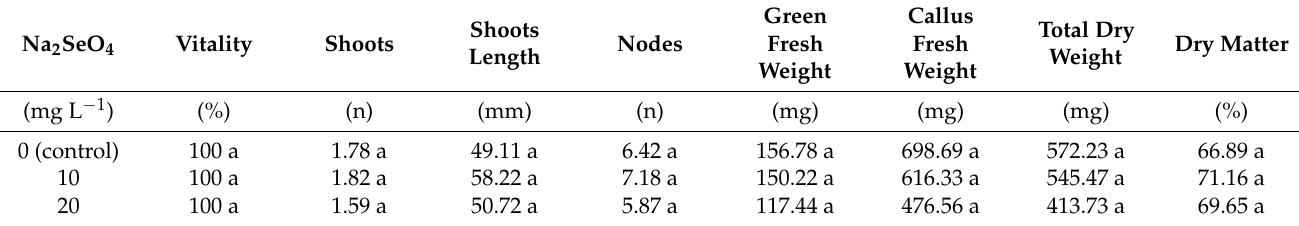
Table 3. Average values of the three subcultures for proliferated explants of the ‘Frantoio’